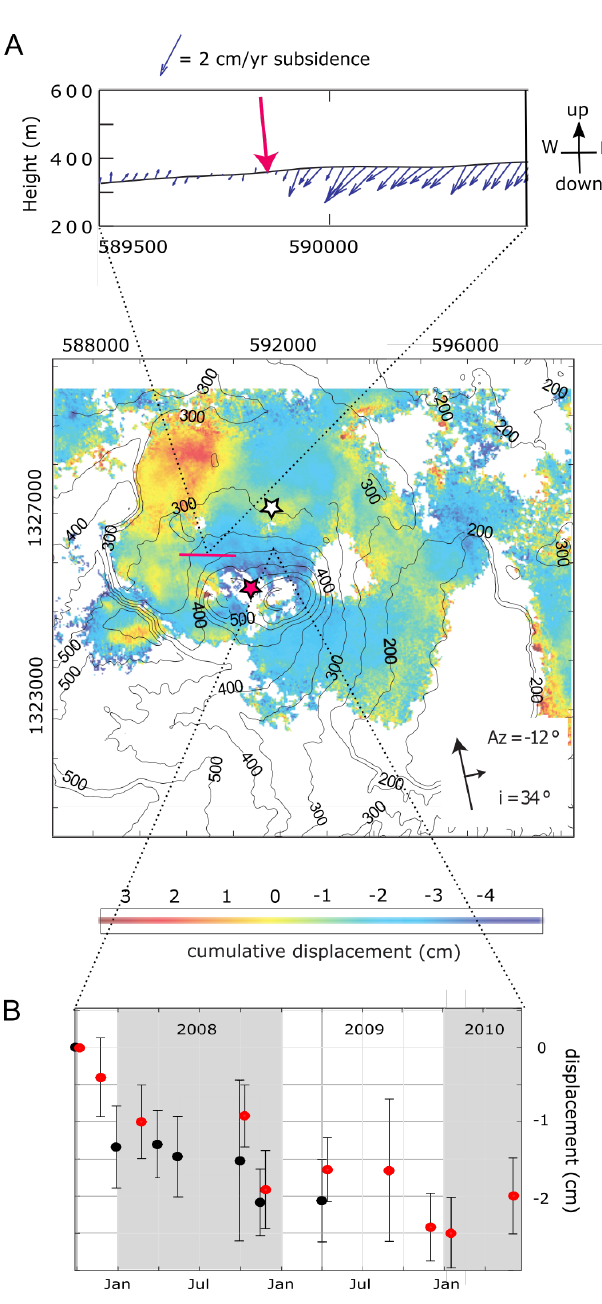
Figure 8: InSAR-measured total displacements between 10 October 2007 and 2 June 2010 from ALOS-1 imagery (central panel) shown relative to the average phase in the part of the interferogram outside Masaya’s caldera (grid in UTM coordinates). Note that this individ- ual interferogram includes representative atmospheric phase contributions as well as the phase changes that we attribute to subsidence. Contours show topographic height above sea level. The white star indicates the po- sition of the best-fit spherical source found by Stephens and Wauthier [2018], and the pink star shows the lo- cation of the conduit source proposed by Stephens et al. [2017]. The spatial extent of the transient deforma- tion identified by Stephens et al. [2017] during explo- sive eruptions in 2012 is indicated by a dashed pink line. The inset profile [A] uses blue arrow size to show total cumulative displacement (derived from ascend- ing track), while directions indicate the sense of mo- tion found from inversion of a pair of ascending and descending interferograms (assuming that north-south motion captured in interferograms is negligible; uncer- tainties in direction are expected to be of the order of 20 degrees). A pink arrow marks the inferred loca- tion of the ring fracture from other geophysical meth- ods. The inset time series [B] is constructed from both ascending (red circles) and descending (black circles) images. Random noise of mean magnitude 1 cm was added to every pixel before inversion, neglecting the e ff ects of spatial correlation. Error bars show the stan- dard deviations for 100 Monte Carlo repetitions. Figure adapted from the Supplementary material presented by Stephens et al.